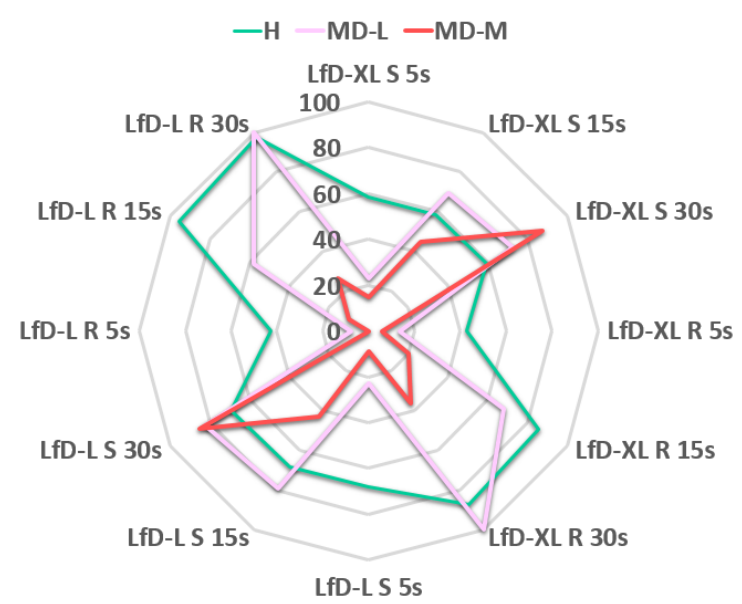
Figure 13. HUMANISE Risk Management ( ∆ Risk Level Prediction) analysis along time (30 s) over LfD-XL and LfD-L for a Healthy worker (H, green), a worker suffering from low-level anxiety (MD-L, purple) and a worker suffering from medium-level anxiety (MD-M, red).